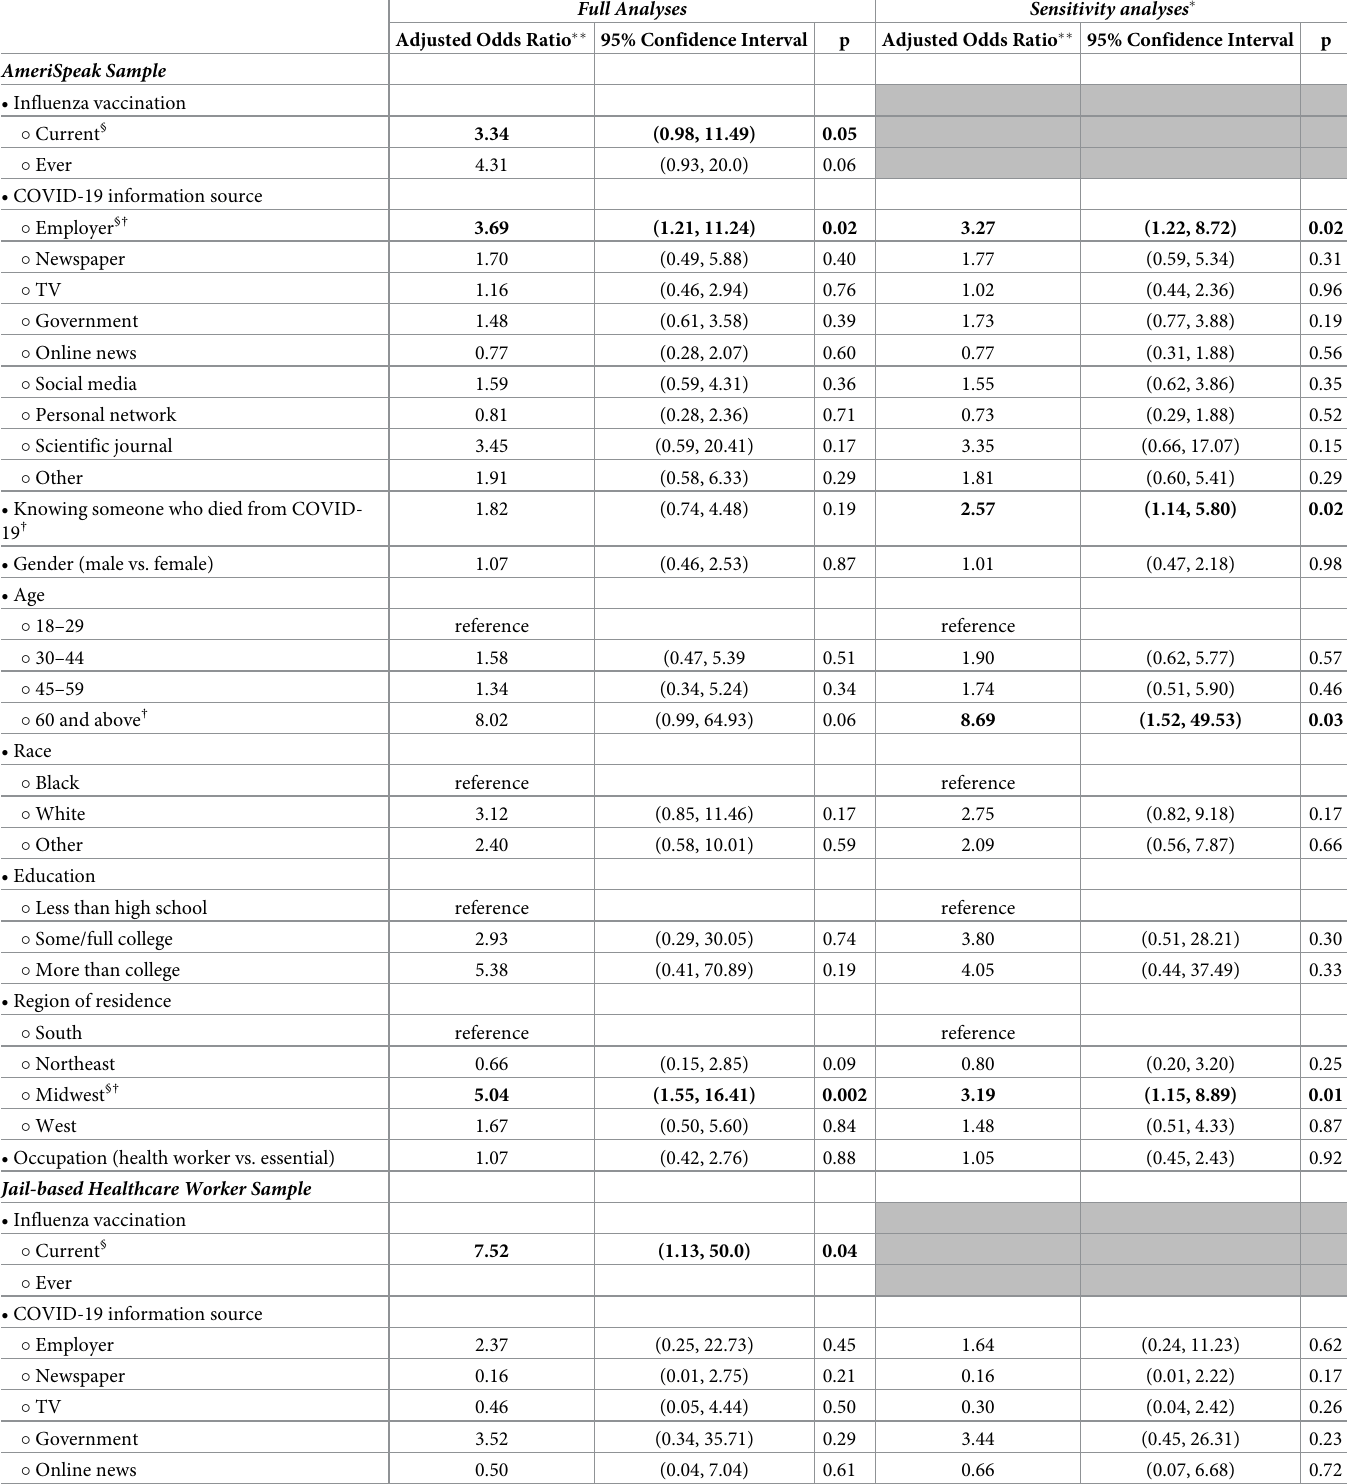
Table 3. Factors associated with COVID-19 vaccine willingness, based on logistic regression (full models and sensitivity